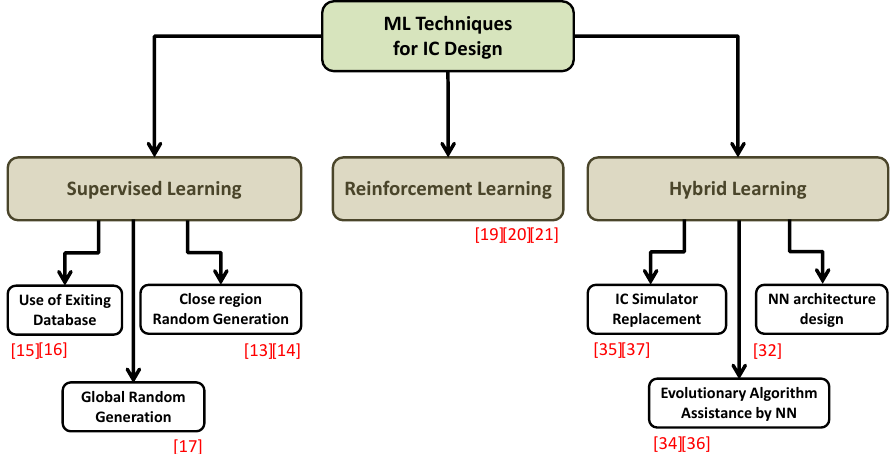
Figure 9. Classification of all the studied techniques in the prior state-of-the-art.